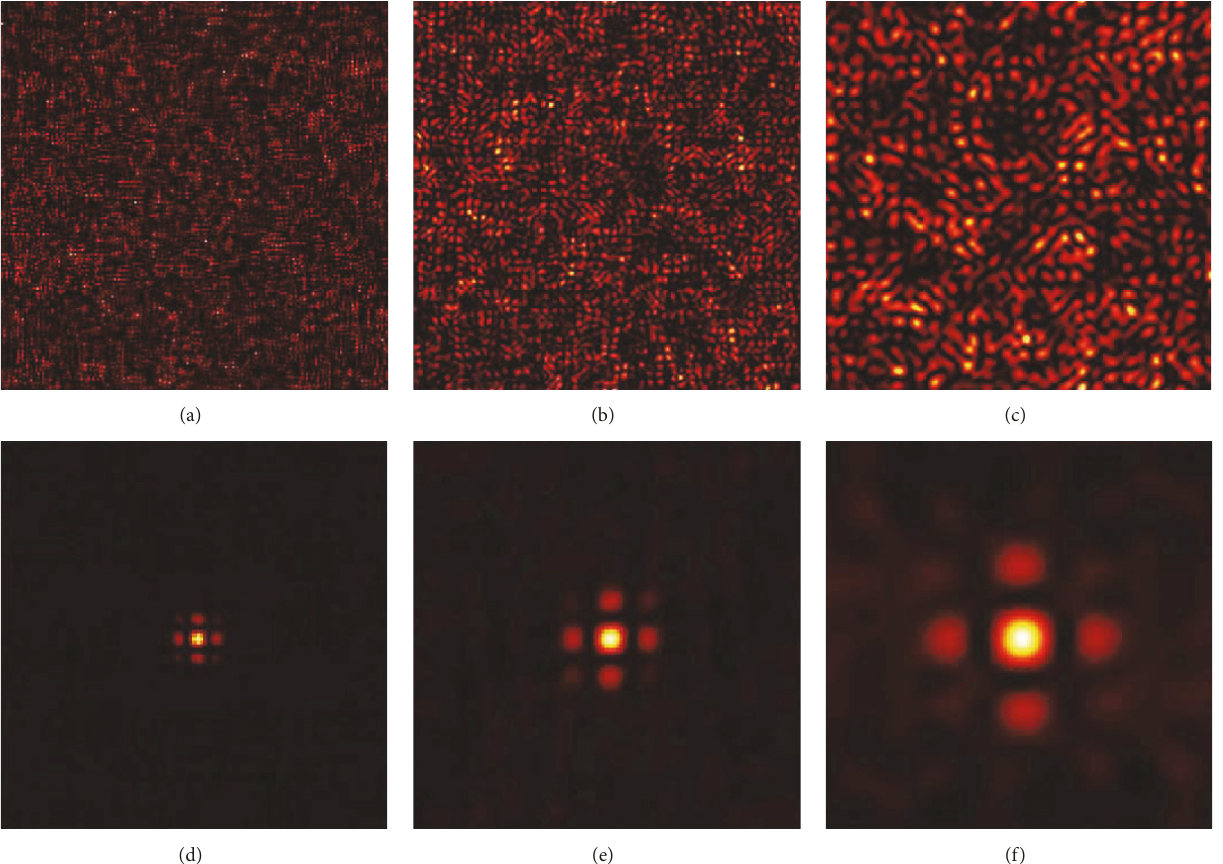
Figure 2: The simulation of speckle pattern in the source plane and corresponding to the autocorrelation for different 𝛿 with 𝑛 = 1 , (a), (d) 𝛿 = 3 mm, (b), (e) 𝛿 = 6 mm, and (c), (f) 𝛿 = 12 mm.